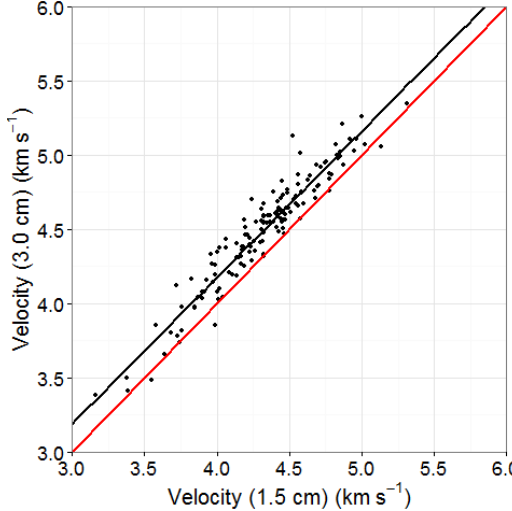
Figure 4. Relationship between standing tree acoustic velocity measured at horizontal depths of 1.5 and 3.0 cm in the stem (R 2 =